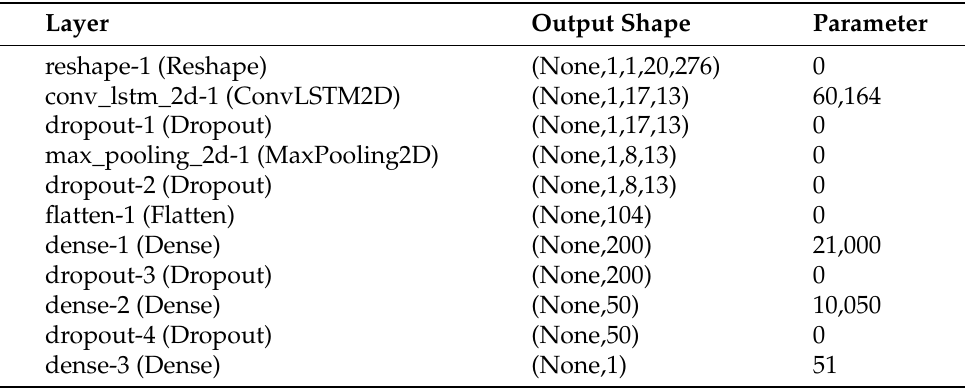
Table 1. Parameters of the LRCN